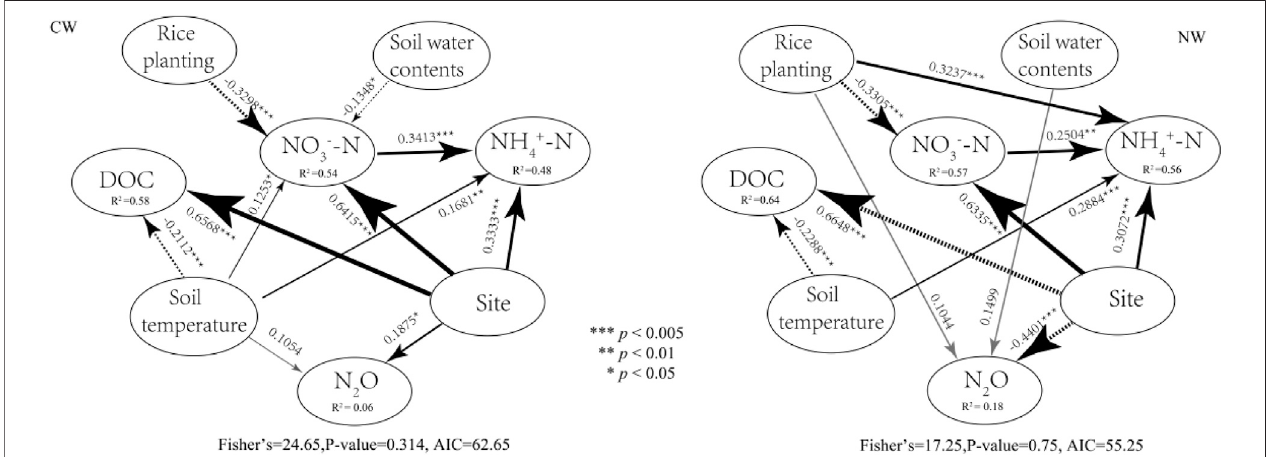
FIGURE 5 | Structural equation model. SEMs assessed direct and indirect associations between soil temperature (ST), soil water content (SWC), ammonium nitrogen (NH 4+ -N), nitrate-nitrogen (NO 3 − -N), and dissolved organic carbon (DOC) and N 2 O fl uxes. Numbers adjacent to the arrows are standardized path coef fi cients, analogoustorelativeregressionweights,andindicatetherelationship ’ seffectsize.Double-headedarrowsindicatecovariancebetweenvariables;single-headedarrows indicate a one way directed relationship. Solid lines indicate positive associations. Dashed lines indicate a negative association. The width of the arrow is proportionalLinewidthisproportionaltothestrength ofpathcoef fi cients. Theproportionofvarianceexplained(conditional R 2 )appearsbeloweveryresponsevariablein the model.